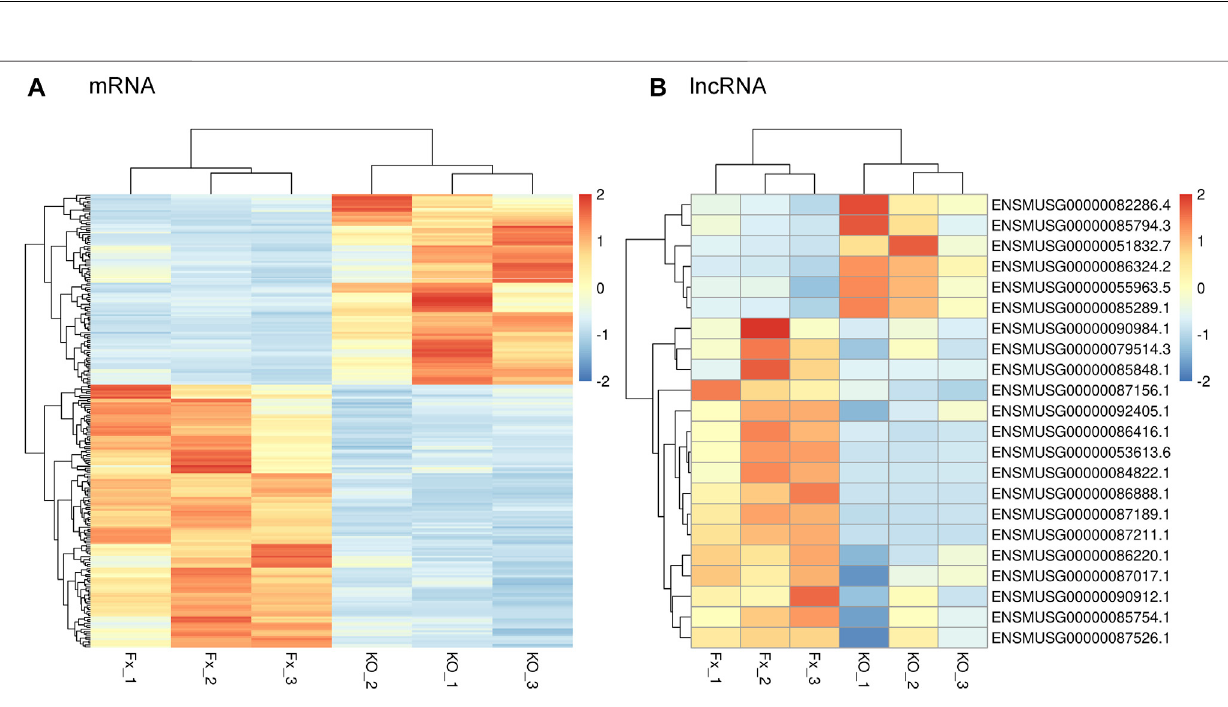
Frontiers in Genetics |